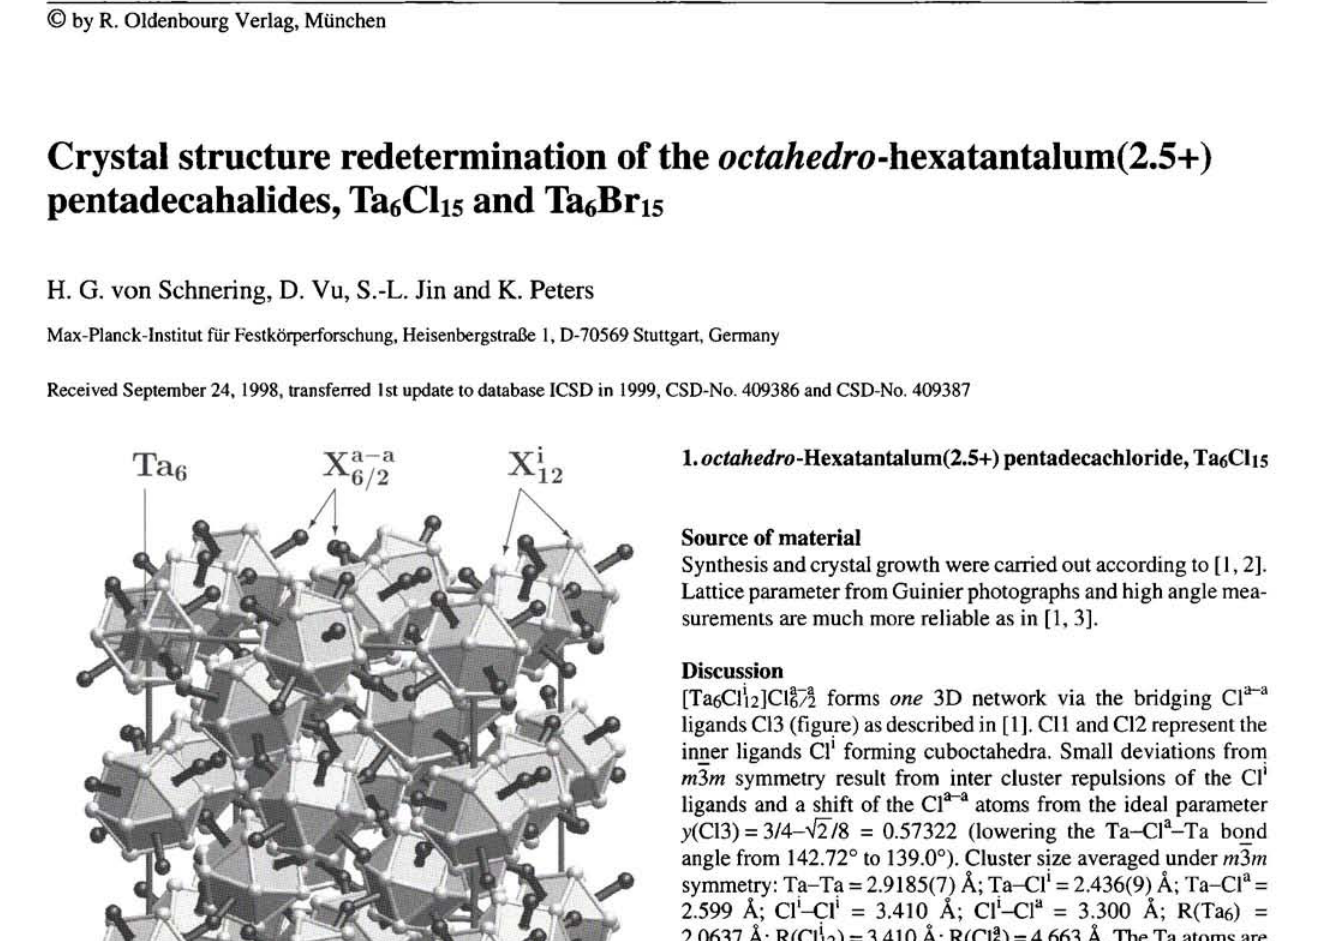
Table 1. Data collection and handling.